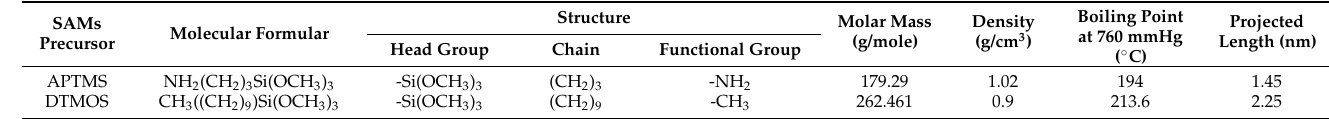
Table 1. Chemical formula and properties of APTMS and DTMOS